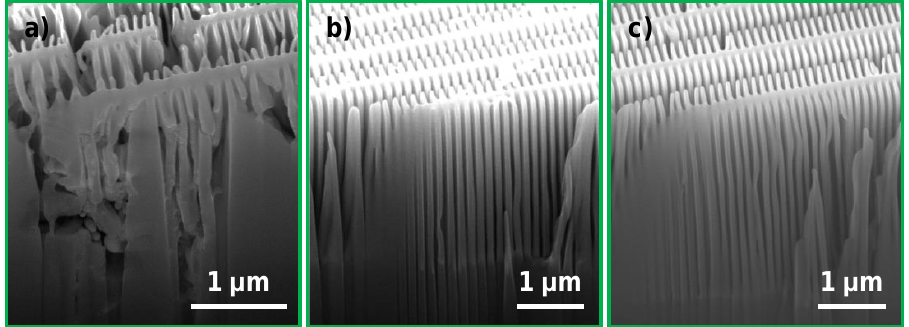
Figure 7. Cross-section SEM micrographs of the fishbone design catalyst processed at MACE condition ( a ) C1 for 9 min, ( b ) C3 for 12 min and ( c ) C4 for 12 min. The cross-sections were made by FIB